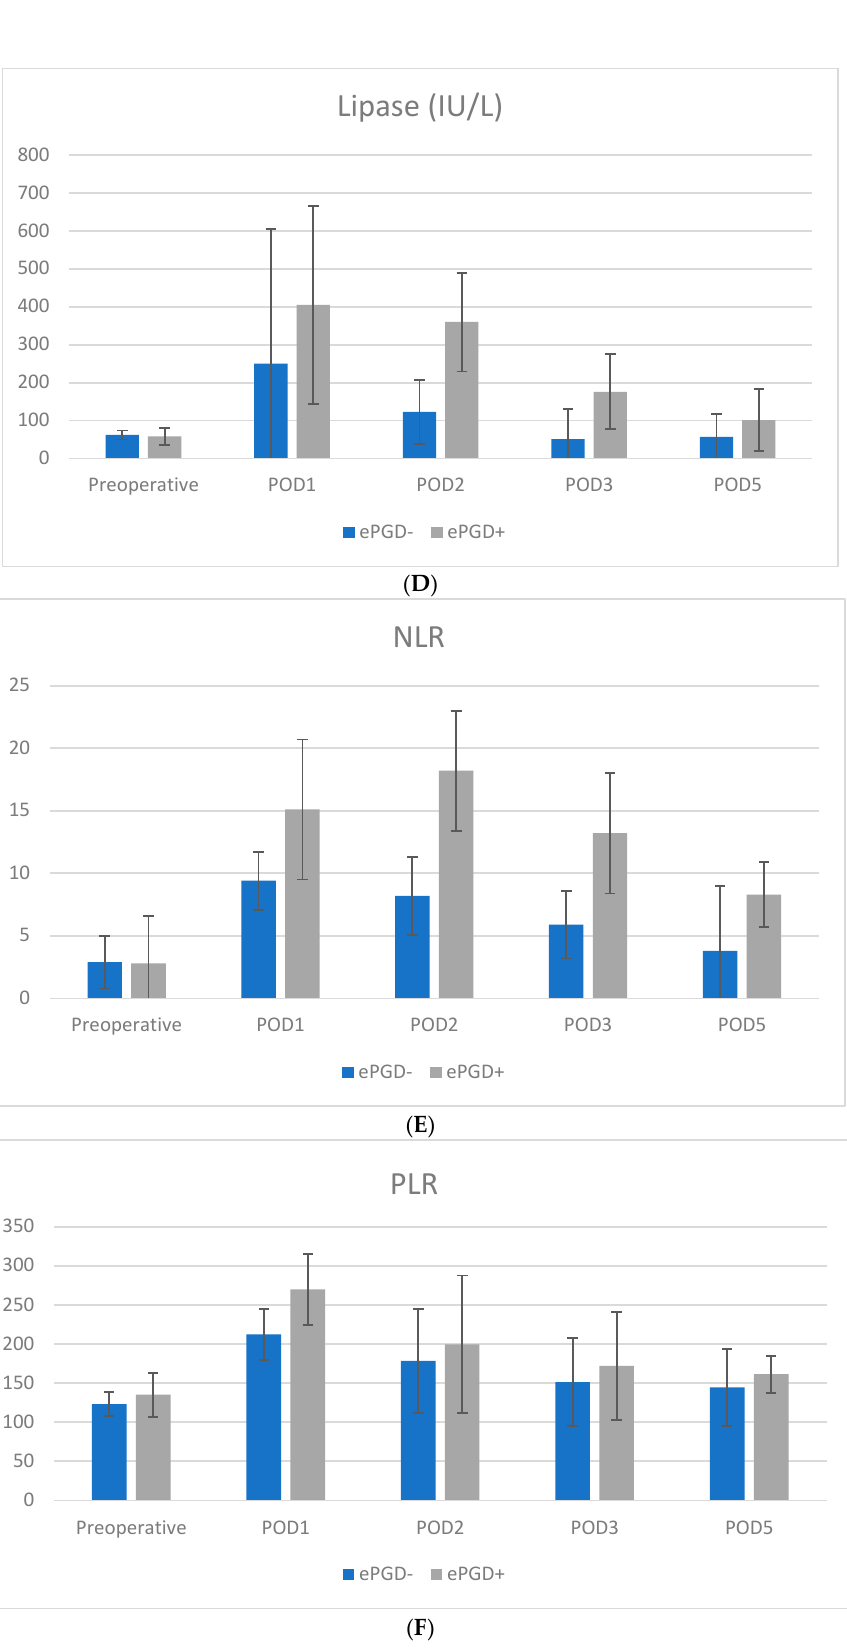
Figure 1. Box plots showing the distribution of WBC ( A ), PCT ( B ), CRP ( C ), Lipase ( D ), NLR ( E ) and PLR ( F ) levels in the ePGD and non-ePGD group preoperative and on POD 1, 2, 3 and 5 following